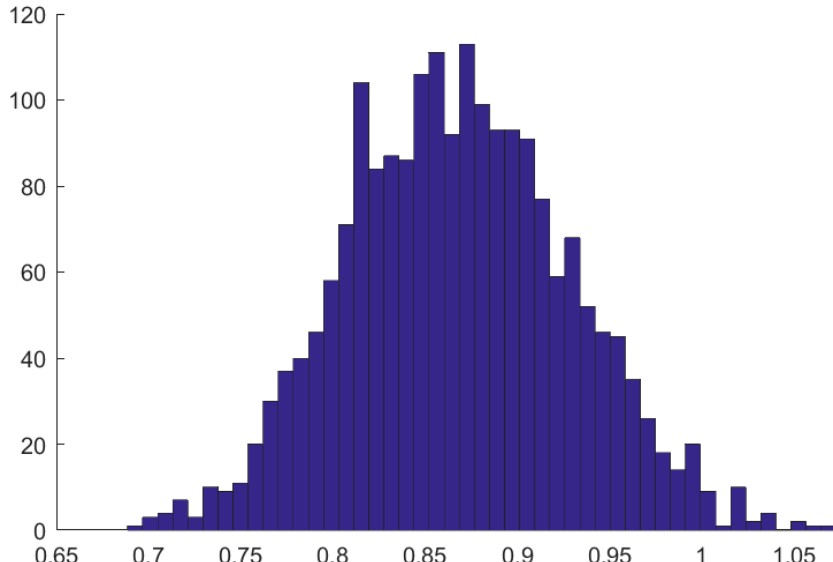
Figure 10. Statistical distribution chart of peak oil leakage rate.